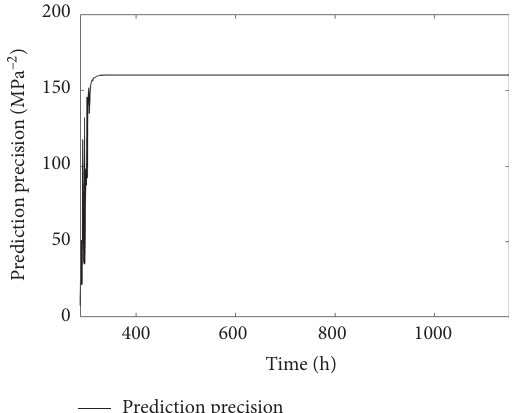
Figure 10: One-step prediction precision.